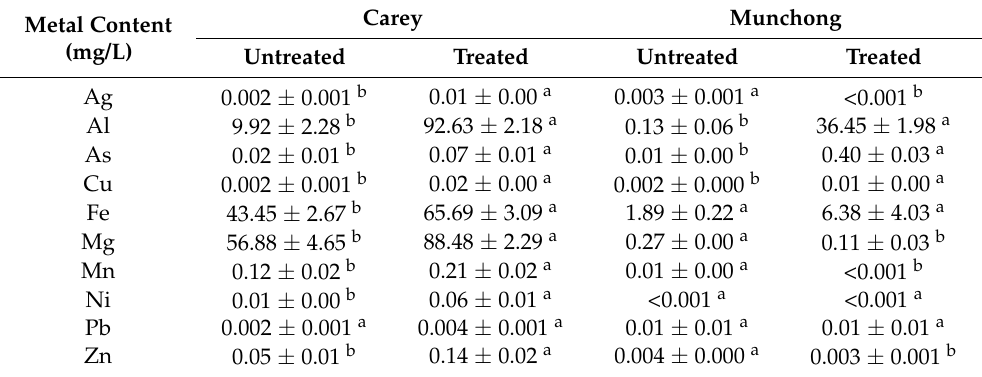
Figure 3. XRD (powder X-ray diffraction) graph showing peaks for mineralogy identification: ( a ) Carey clay soil; ( b ) Munchong clay soil. Table 6. Soluble metal content in untreated and treated Carey and Munchong